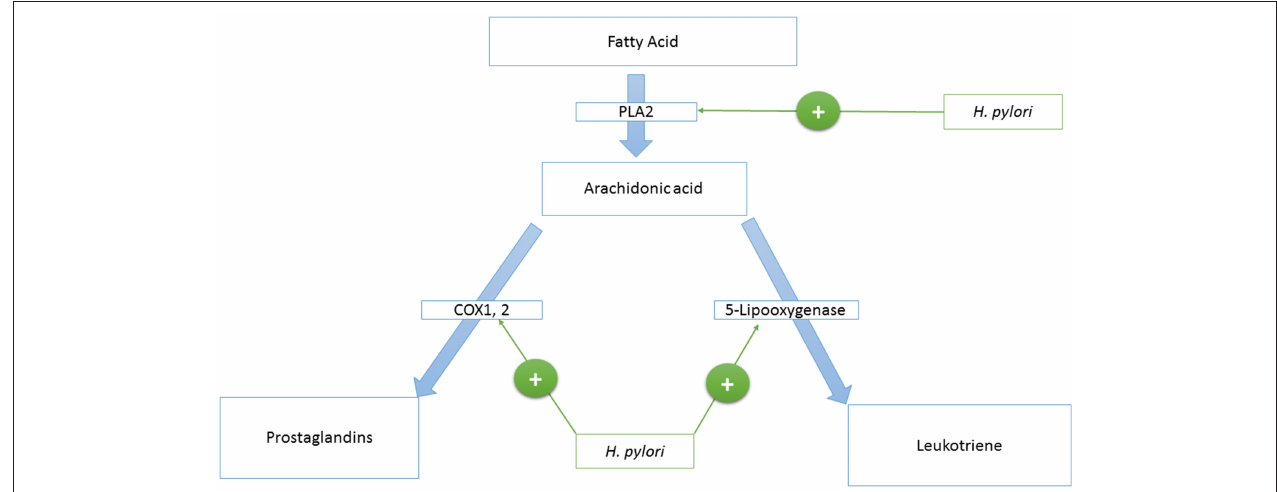
FIGURE 1 | A model that represents the H. pylori —host’s eicosanoids interactions.